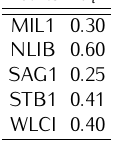
Figure 1. Relationship between α 2001).